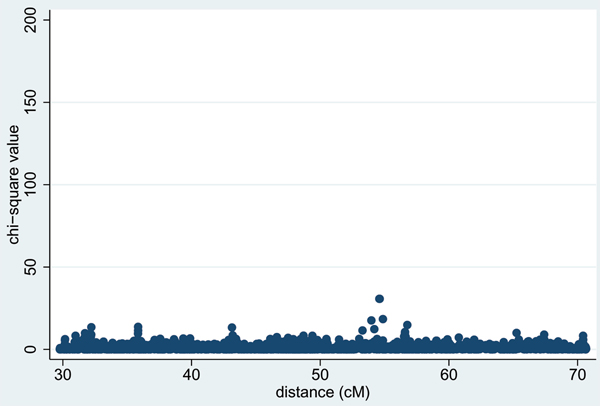
Residual association after stepwise regression. Results are shown after accounting for SNPs 3437 and 3439 (Replicate 1).